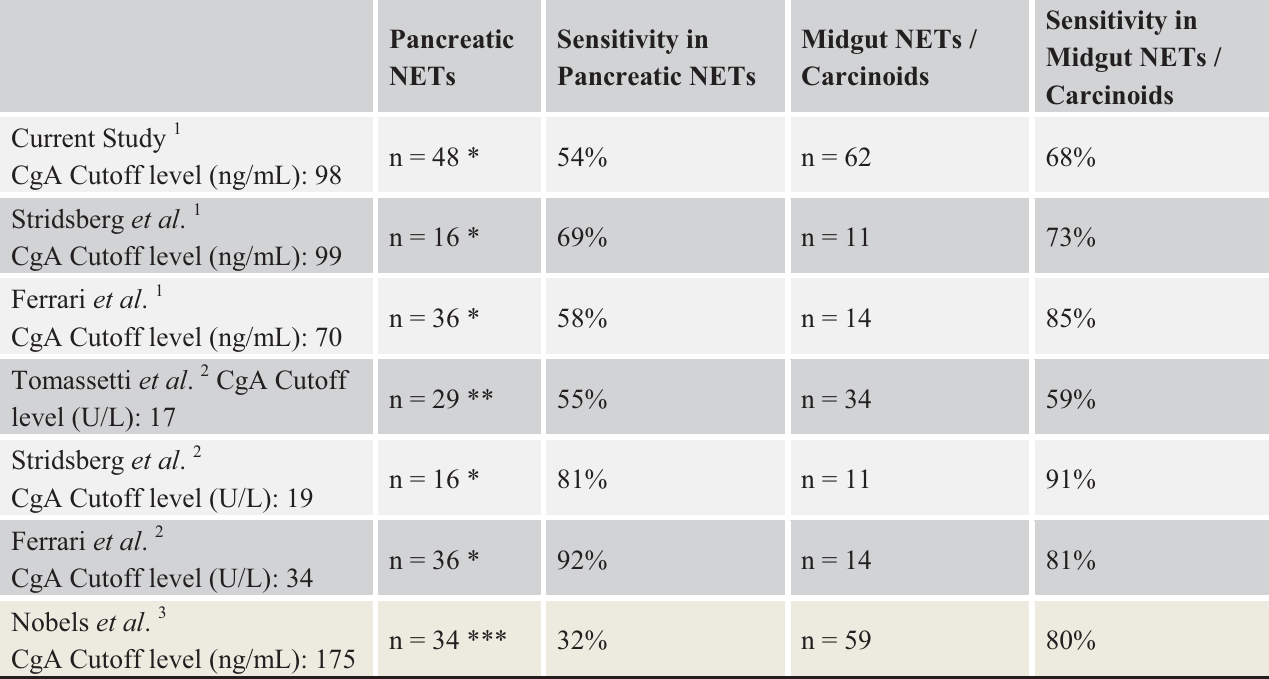
Table 10. CgA sensitivities in NETs classified in pancreatic and midgut NETs depending on tumor primary and assay (CIS-bio IRMA kit, DAKO ELISA kit, in-house RIA). Sensitivity in Pancreatic Sensitivity in Midgut NETs / Midgut NETs / NETs Pancreatic NETs Carcinoids